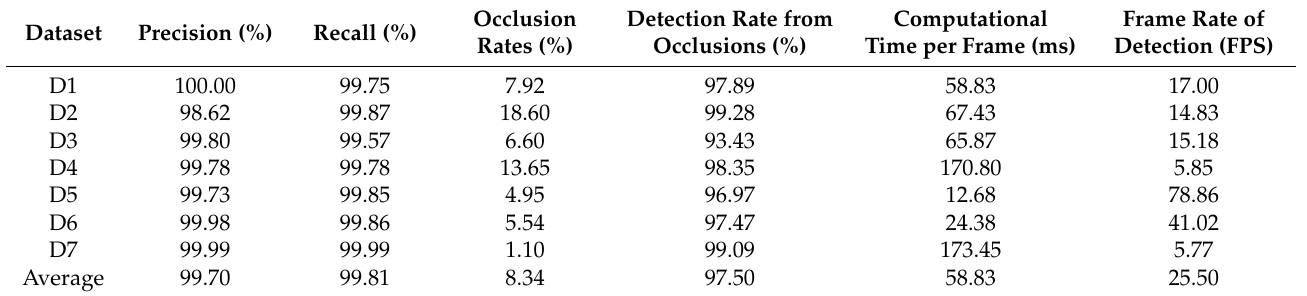
Table 2. Performance analysis of the proposed fish detection method.